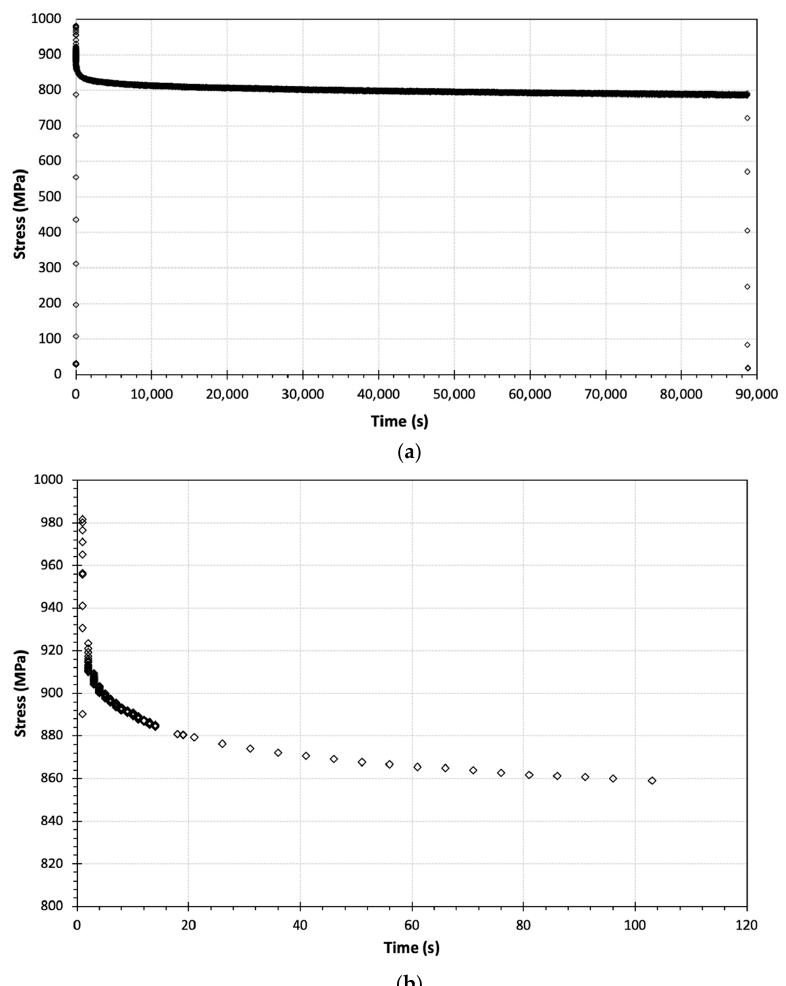
Figure 8. ( a ) Stress relaxation under a fixed strain of 1.5% during 24 h ; ( b ) relaxation during initial 2 min.